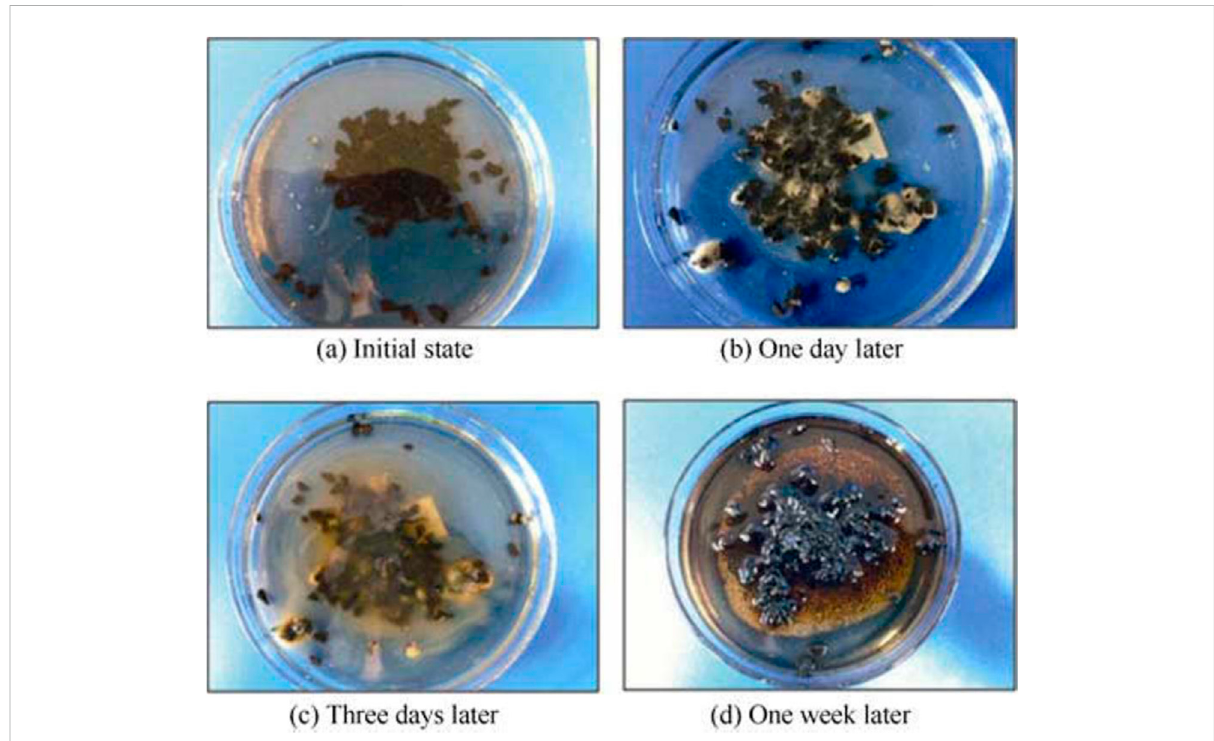
FIGURE 7 Morphology change of shale cuttings immersed in a solution of a biomimetic wellbore-strengthening agent with time. (A) Initial state, (B) one day later, (C) three days later, and (D) one week later.